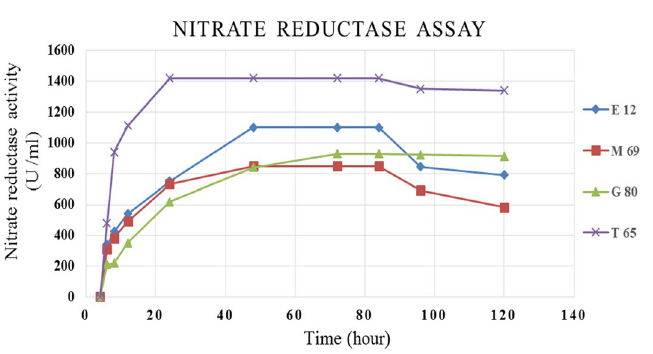
Figure 2. Time course of enzyme production around 120-h incubation of selected